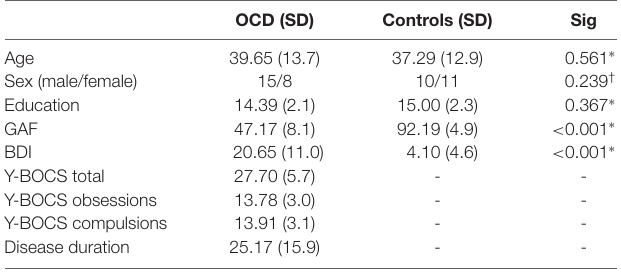
TABLE 1 | Comparison between some sociodemographic and clinical features of obsessive-compulsive disorder (OCD) patients vs. healthy controls.